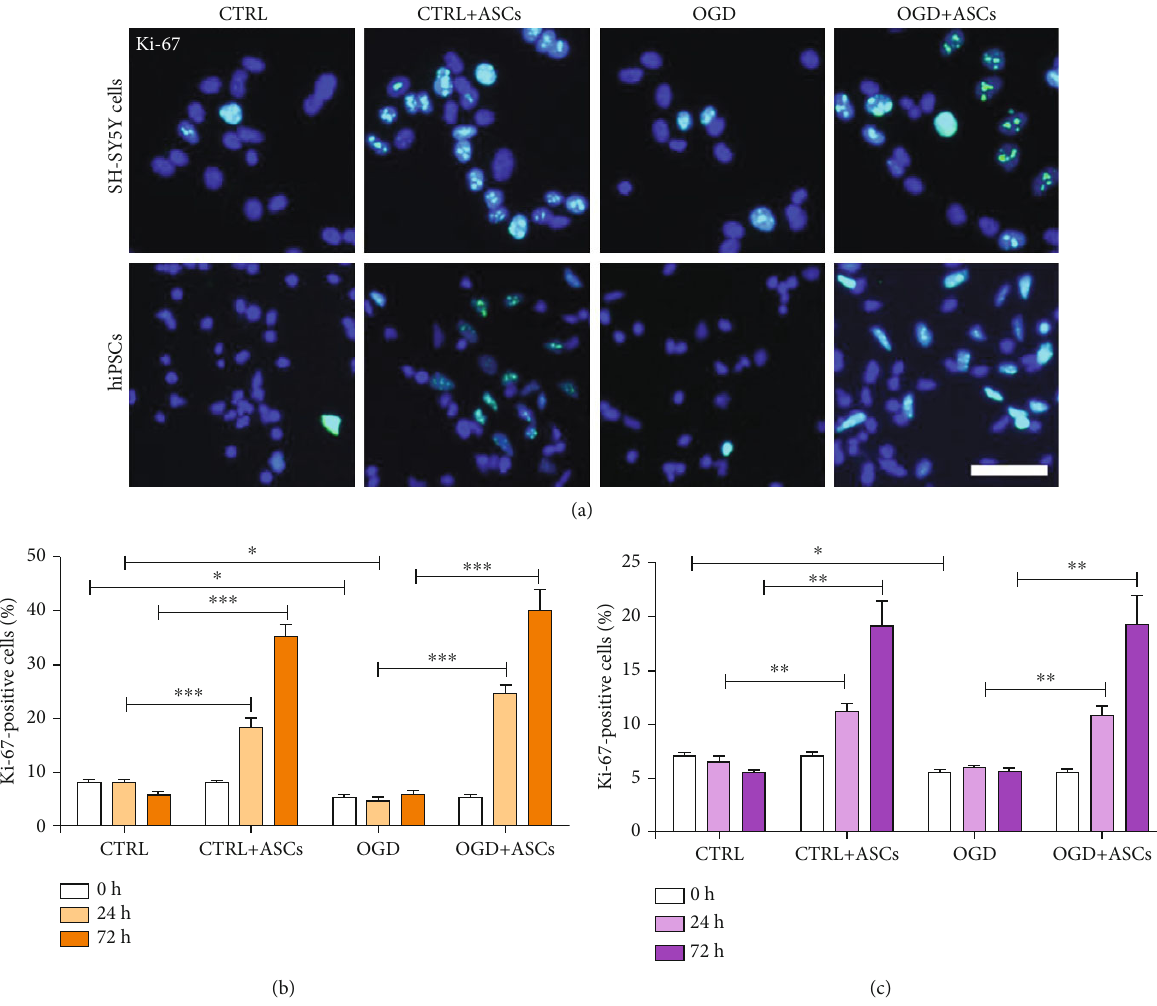
Figure 5: Proliferation of SH-SY5Y- and hiPSC-neurons after OGD and ASC coculture. (a) Representative images of Ki-67 staining after OGD and 72h after reperfusion in SH-SY5Y- and hiPSC-neurons. Blue =nuclei; green =Ki-67. Scale bar, 50 μ m. (b) Quanti fi cation (%) of Ki-67-positive SH-SY5Y- and (c) hiPSC-neurons. Two to four representative images (two to four independent experiments) of SH-SY5Y- neurons and 4 representative images (two independent experiments) of hiPSC-neurons were analyzed. All statistical analyses were performed using an independent t -test, statistical signi fi cance: ∗∗∗ p < 0 : 001 , ∗∗ p < 0 : 01 , and ∗ p < 0 : 05 . All quantitative data are presented as the mean ± SEM